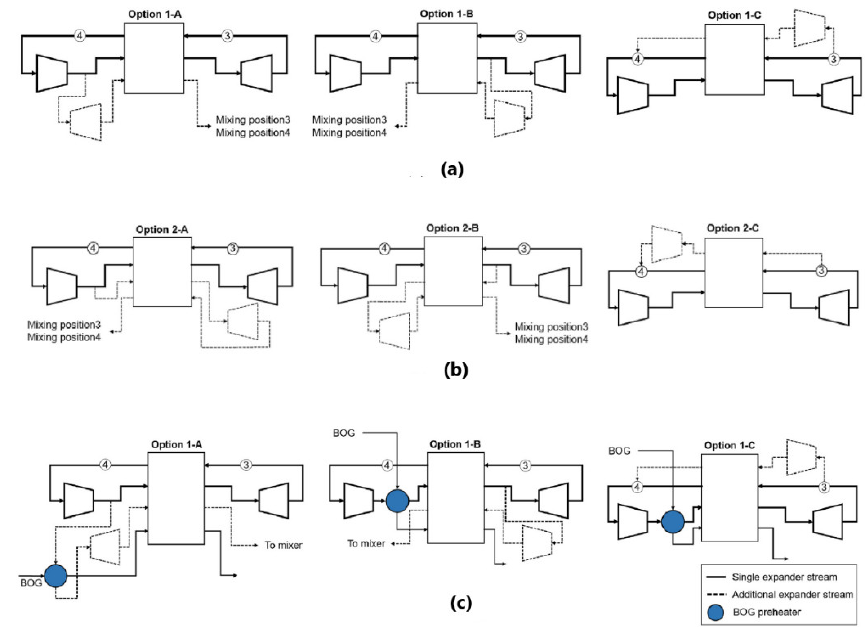
Figure 19. Design options considered for the structural optimization of dual expander systems: ( a ) Option 1; ( b ) Option 2; ( c ) Heat exchange of BOG preheater [55]. Reproduced with permission from Elsevier (license number